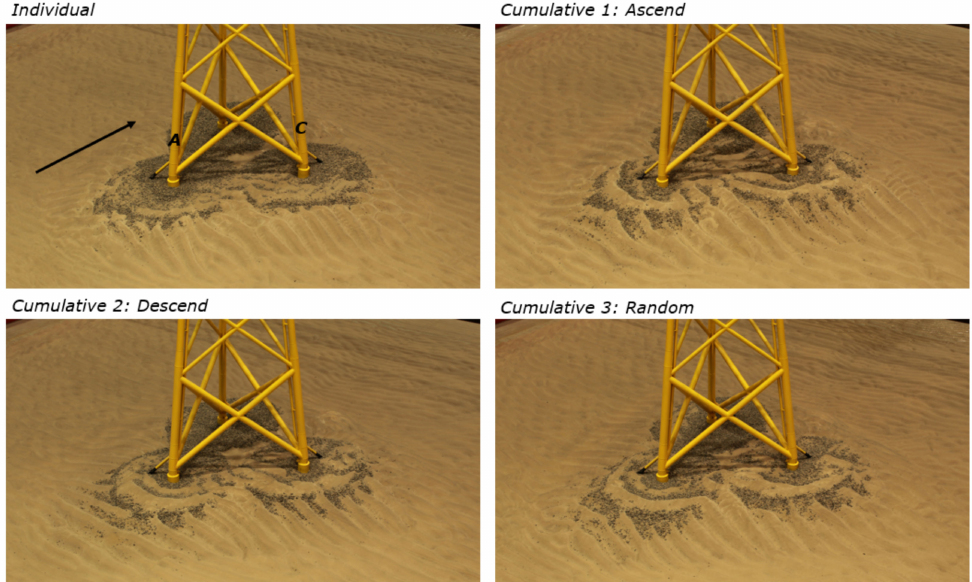
Figure 8. General view of the platform during the tests: top left : individual, top right : cumulative ascending, bottom left : cumulative descending, bottom right : cumulative random.